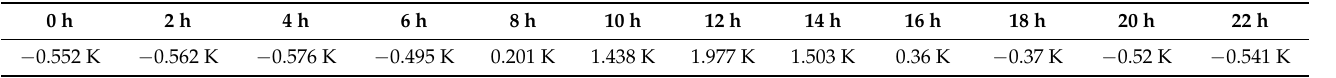
Figure 3. Diurnal air temperature course in comparison for open field stations and forest stations. In Table 3, mean differences are provided. The largest differences between the mean values in the open field and in the forest appear at 04:00 o’clock in the morning with − 0.576 K and at noon with +1.977 K, respectively. Table 3. Differences between the mean air temperature values of all stations in the open field and in the